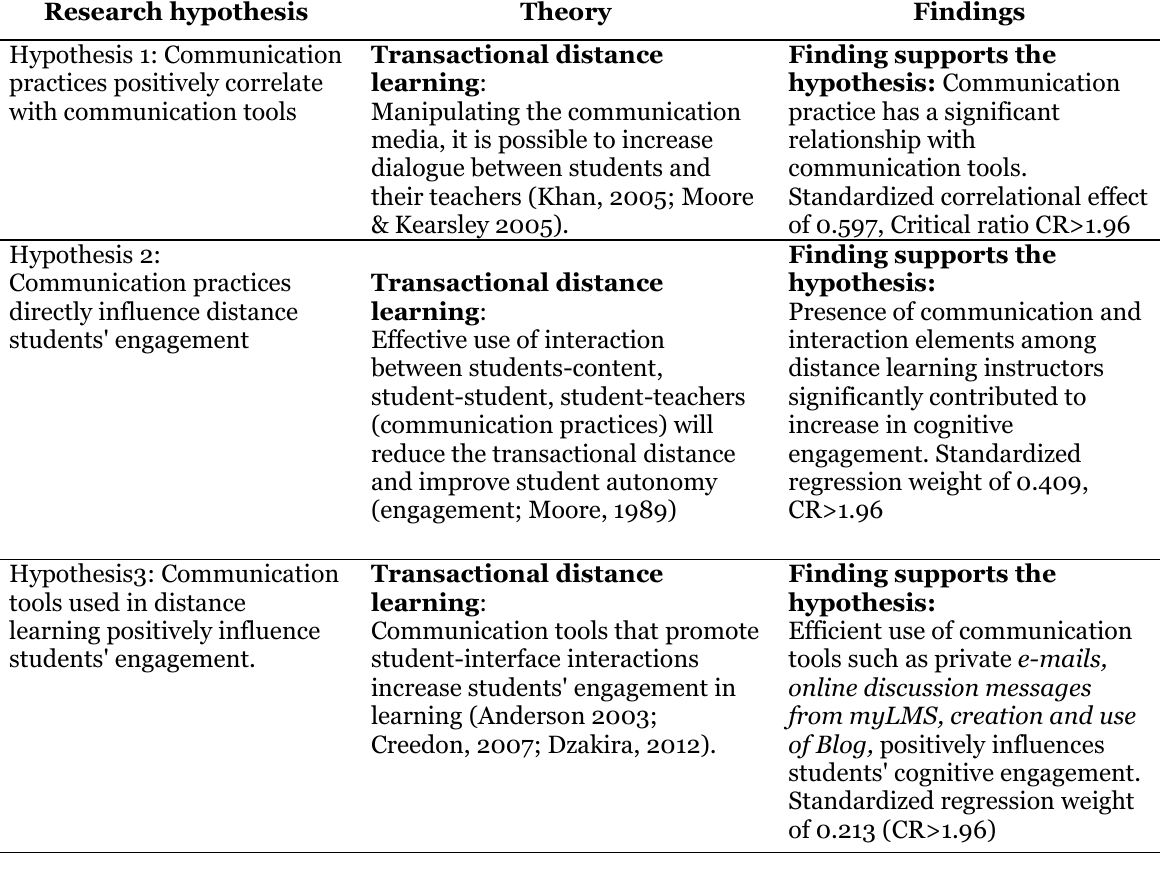
Table 4 Summary of Quantitative Data Analysis and